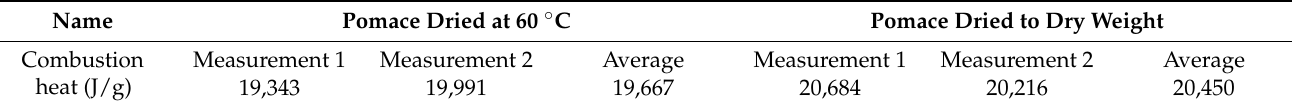
Table 1. Heat of combustion of apple